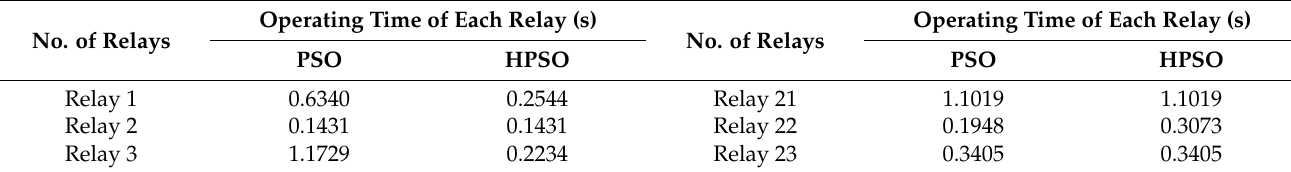
Table 10. Operating time of individual relays for the optimized values of the